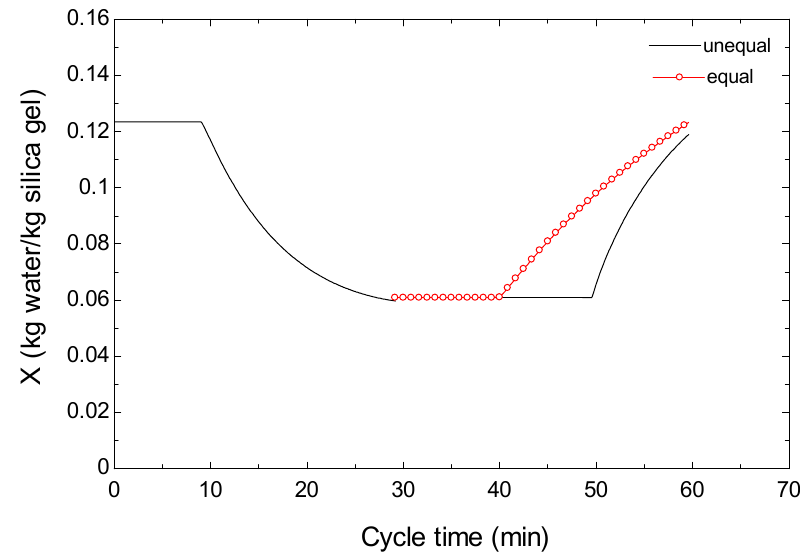
Figure 4. Adsorption capacity rate variation.